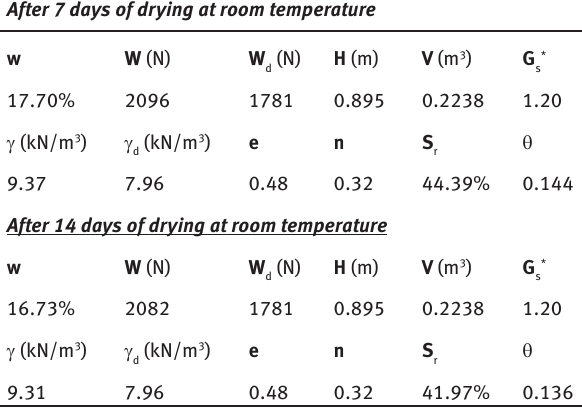
Table 5: Physical-volumetric state of the coal in the prototype model during the drying phases After 7 days of drying at room temperature